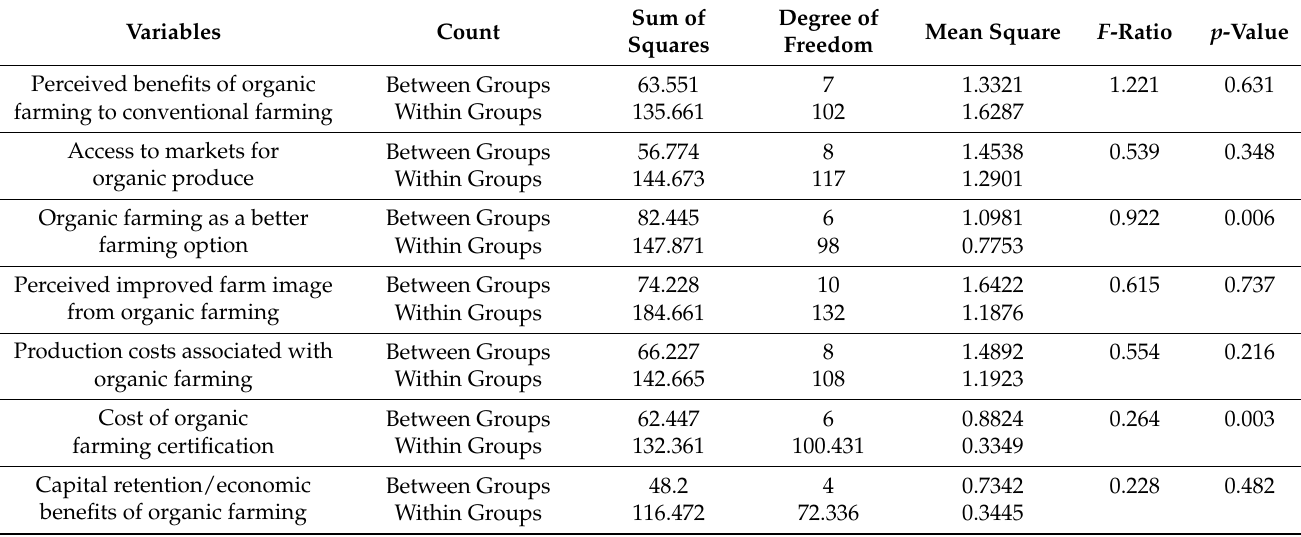
Table 4. ANOVA results on perceptual variables of organic farming in the